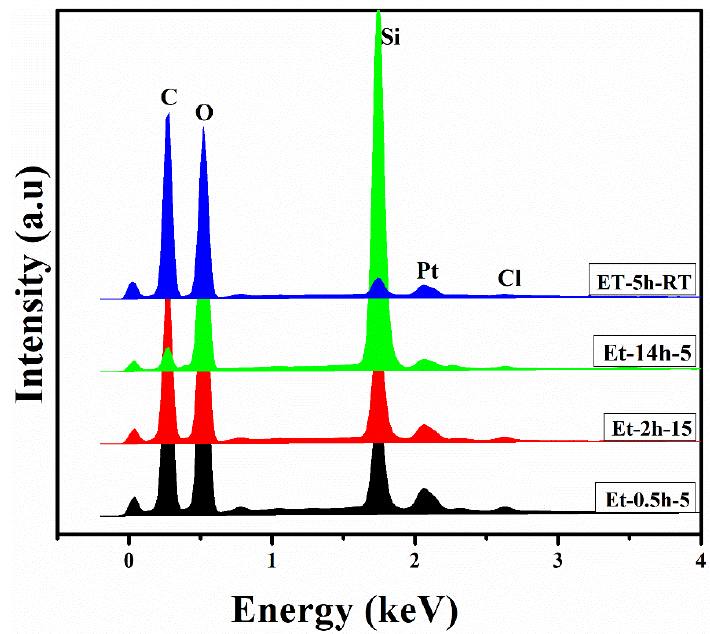
Figure 3. EDS profile of the coated fabrics.